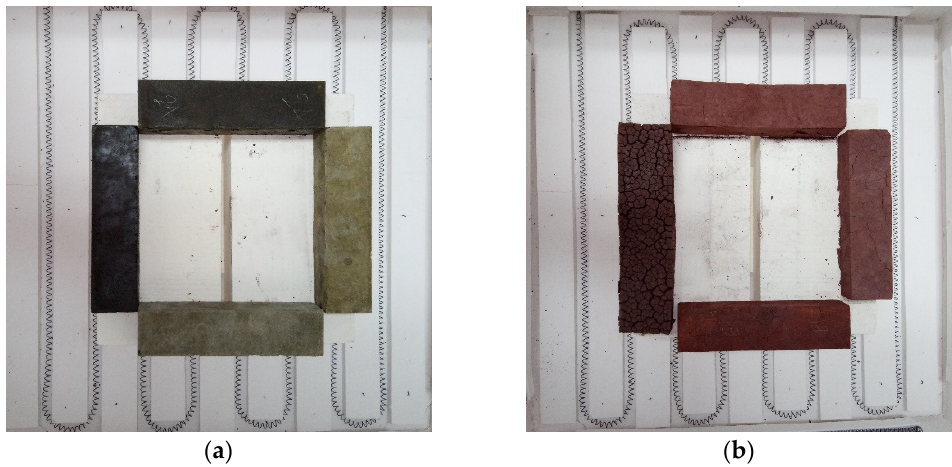
Figure 1. Specimens of different compositions placed in the oven: ( a ) before and ( b ) after thermal load application